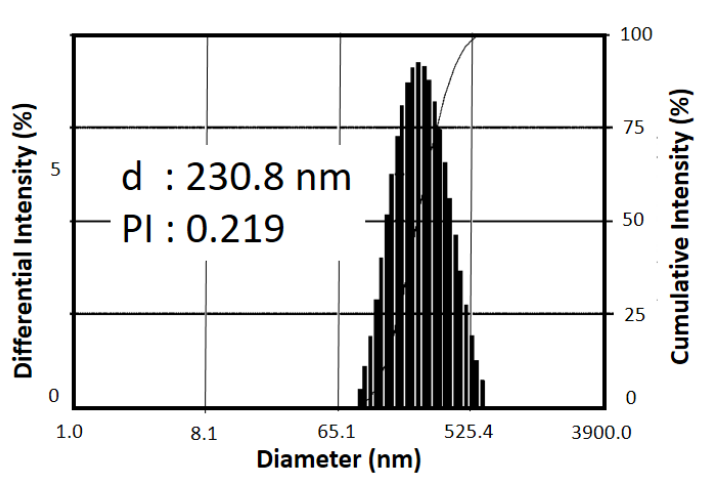
Figure 3. Particle Size Analysis of ZNPs Suspension.